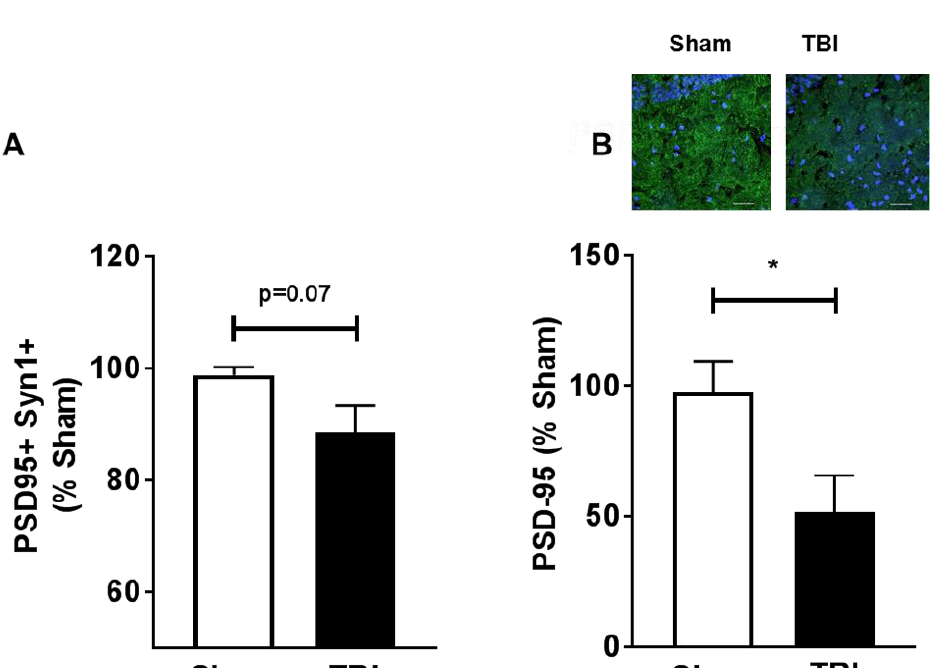
Figure 5. Contusive injury results in chronic synapse loss in the aged brain. ( A ) Hippocampi were collected and synaptosomes were isolated by sucrose gradient followed by size calibration beads, before the co-expression of pre- and post-synaptic markers. The pre-synaptic marker was Synapsin-1 (Syn-1) and the post synaptic marker was post-synaptic density protein 95 (PSD-95). Significant decreases were found in total synaptosome numbers in the TBI (30 dpi) group when compared to sham group; n = 8–9/group. ( B ) Synaptic levels were measured by PSD-95 staining in the dorsal hippocampus. Representative images are shown in the inset. Aged TBI (30 dpi) animals had reduced PSD-95 expression. No reactivity was observed in secondary alone. White scale bar = 30 µm; 200× magnification; i = 4/group (PSD95 in green and cell bodies in blue). Student’s t -test was used to measure differences. Bars depict group means and SEM; * p < 0.05.